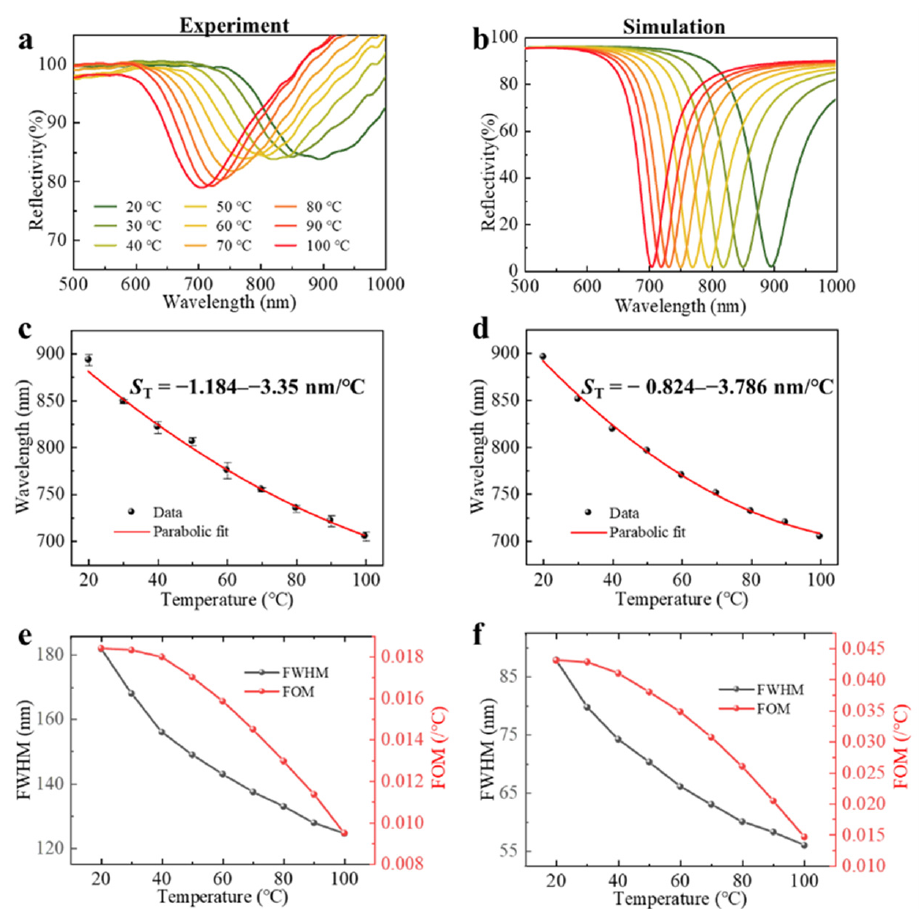
Figure 5. ( a ) Experimental and ( b ) simulated reflection spectra for different temperatures. ( c , d ) Reso- nance wavelengths as a function of temperatures, which correspond with panels ( a ) and ( b ), respec- tively. ( e ) Experimental and ( f ) simulated spectral FWHM and FOM change with temperature.